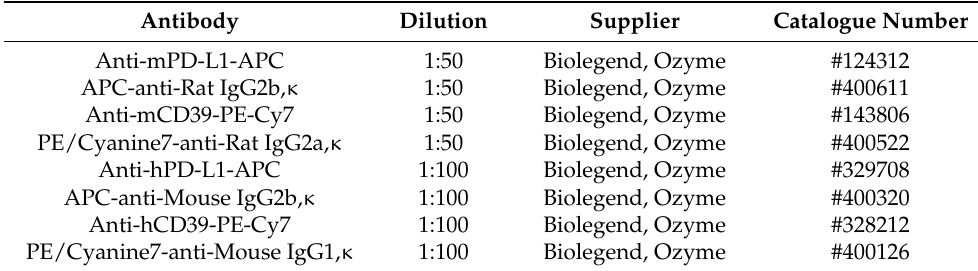
Table 2. CD39 and PD-L1 antibodies used in this